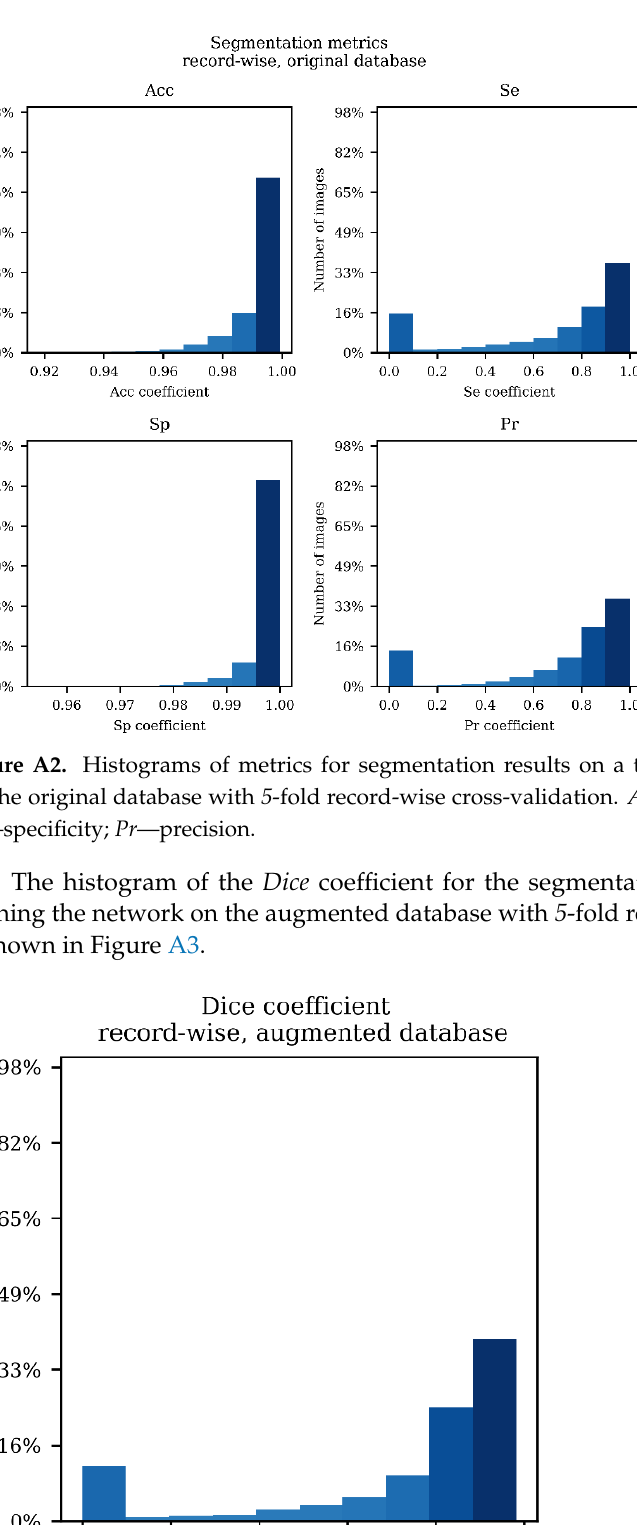
Figure A1. Dice coefficient histogram for segmentation results on a test set for a network trained on the original database with 5 -fold record-wise cross-validation.